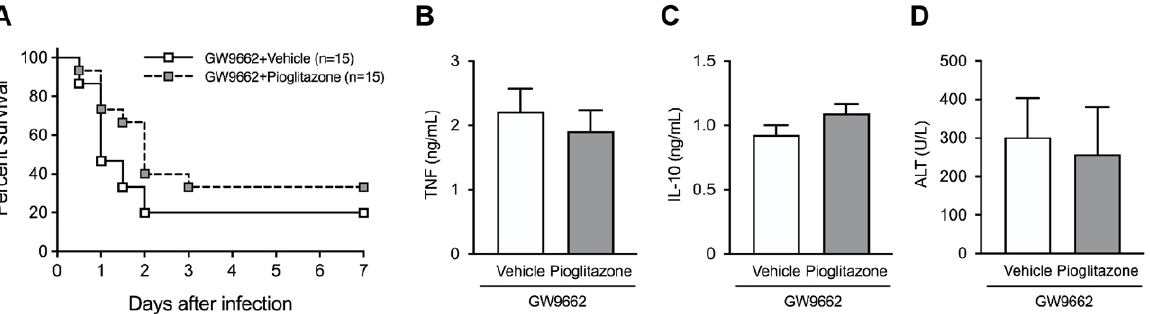
Figure 3. Peroxisome proliferator-activated receptor gamma (PPAR γ ) antagonist, GW9662, abolishes the protective effects of pioglitazone in post-burn infection. ( A ) Survival of burned mice after intravenous infection with E. coli (5 × 10 8 CFU). Serum concentration of TNF at 1 h ( B ), IL-10 at 6 h ( C ), and ALT at 24 h ( D ) after infection. n = 15 per group; pooled data of two independent experiments. Data are represented as the mean ± SD.